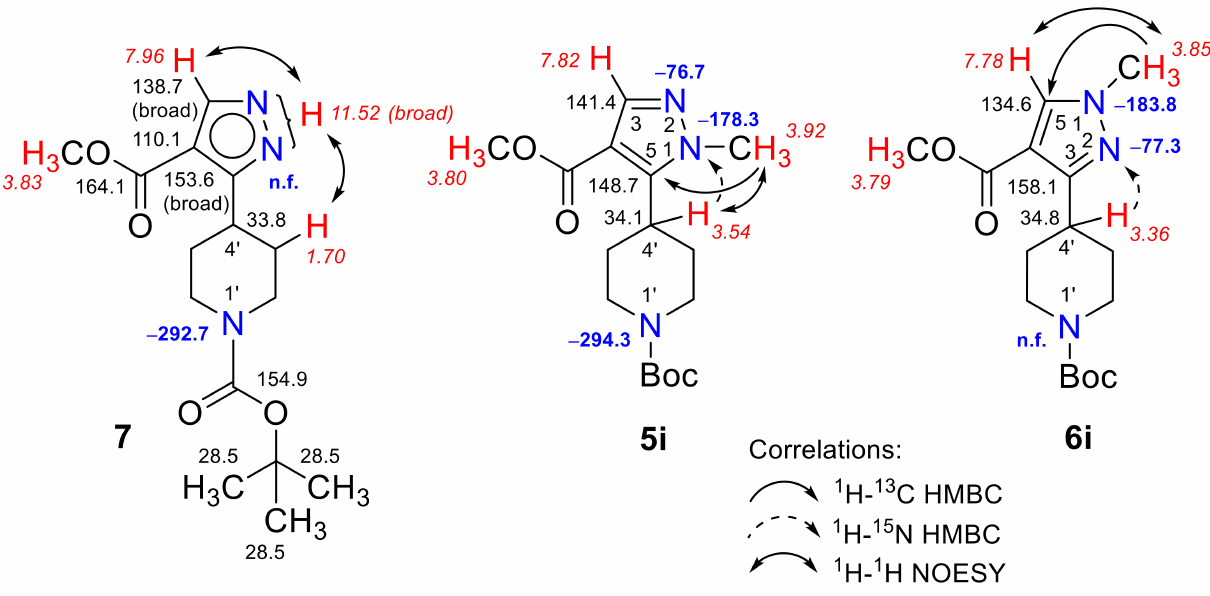
Figure 4. Relevant 1 H- 13 C HMBC, 1 H- 15 N HMBC, and 1 H- 1 H NOESY correlations and 1 H-NMR (italics), 13 C-NMR, and 15 N-NMR (bold) chemical shifts of compound 7 (tautomeric equilibrium of 7a and 7b ) and regioisomers 5i , 6i in CDCl 3 (25 ◦